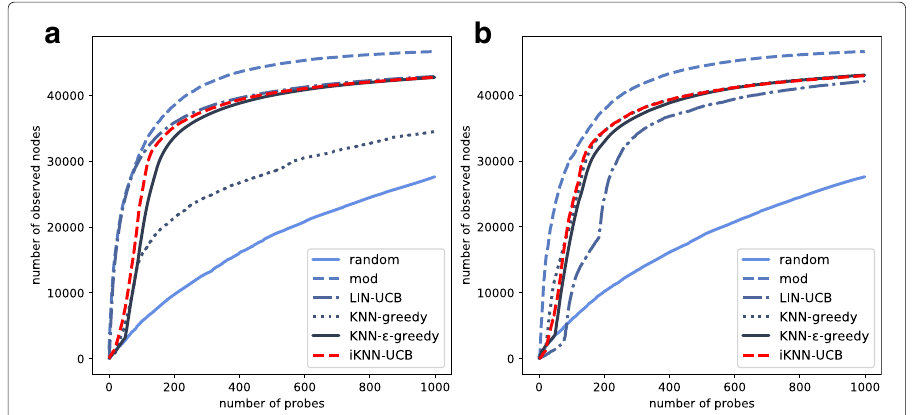
Fig. 3 Performance comparison on scale-free network created by Barabasi-Albert model. (nodes=50000, m = 20) 1000 probing steps run on samples containing 5% randomly selected nodes. a random node (RN) sample b BFS